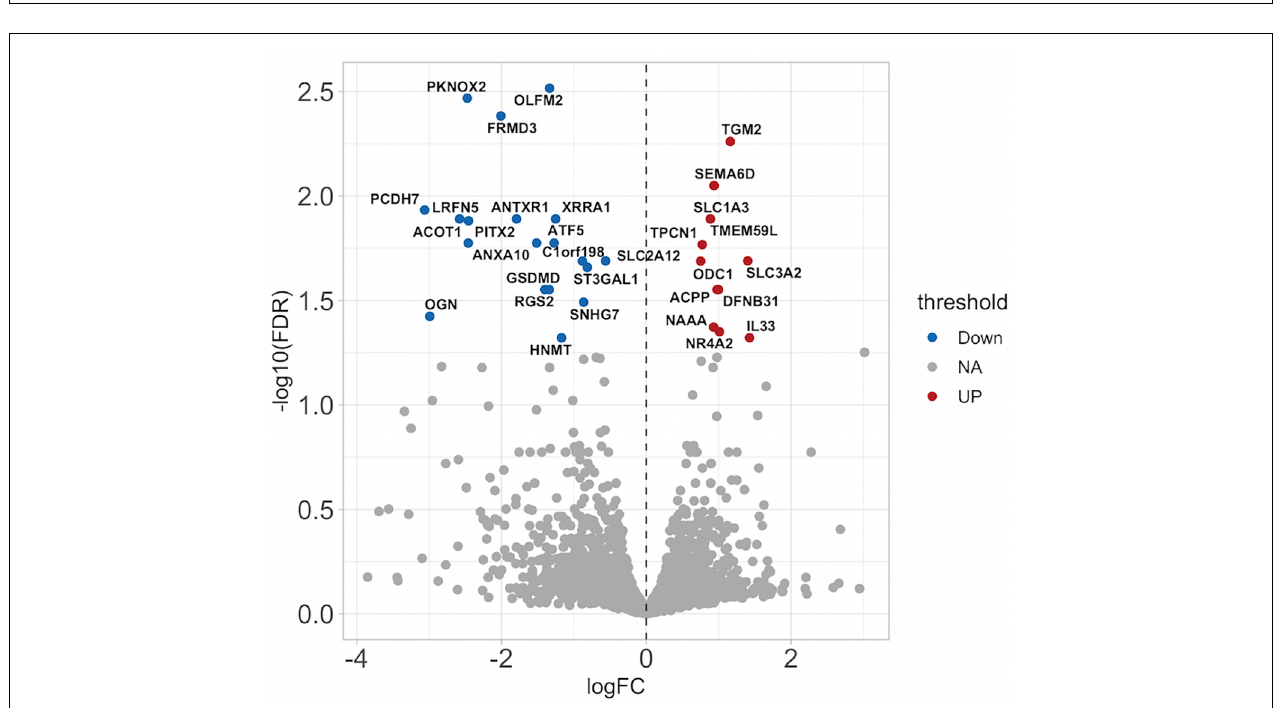
FIGURE 6 | miR-210 inhibition causes differential gene expression in ASMCs stimulated with conditioned medium from BEAS-2B cells. RNA seq analysis was performed on ASMCs stimulated with conditioned medium (CM) from BEAS-2B cells in the absence or presence of a miR210-3p inhibitor. The top 31 differentially expressed genes are labeled. Red indicates upregulation, blue indicates downregulation. FDR, false discovery rate; FC, fold